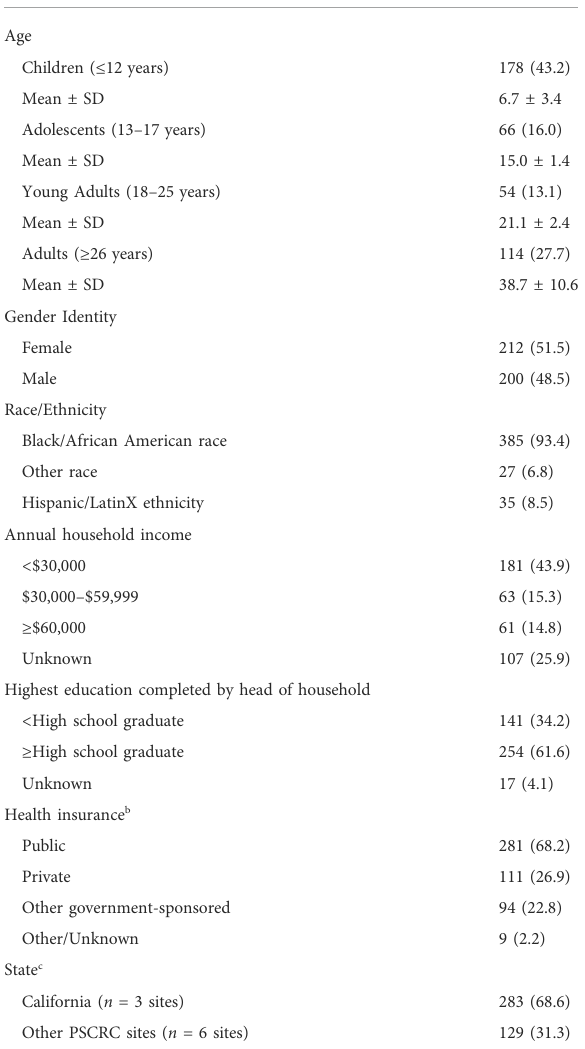
TABLE 1 Participant socio-demographics ( N = 412) a